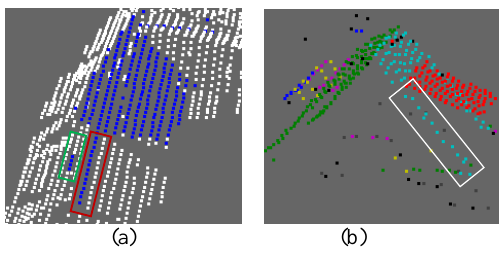
Figure 7. Planes detected by RANSAC. (a) under- segmented planes. (b) Low point density area on roof